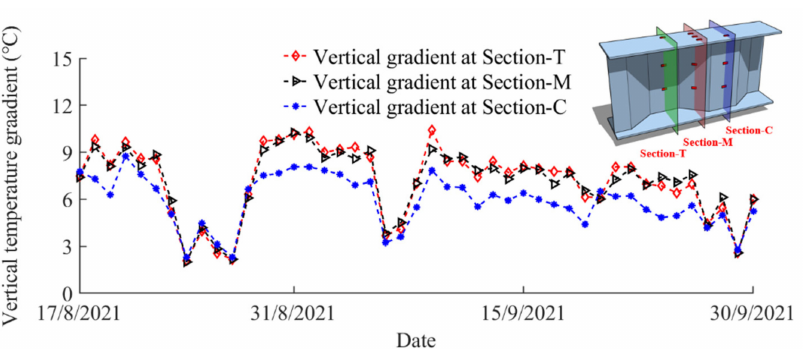
Figure 7. The daily maximum vertical temperature gradient at different